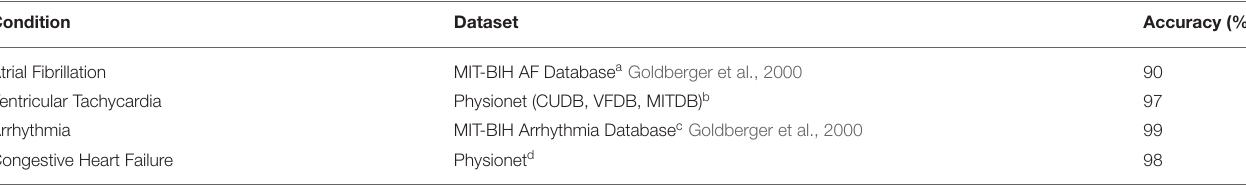
TABLE 6 | Experimental results of the detectors fully validated in